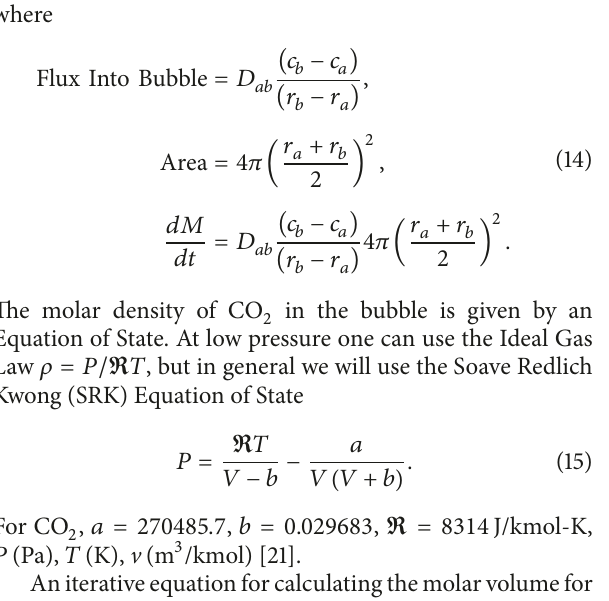
Figure 12: General bubble growth model